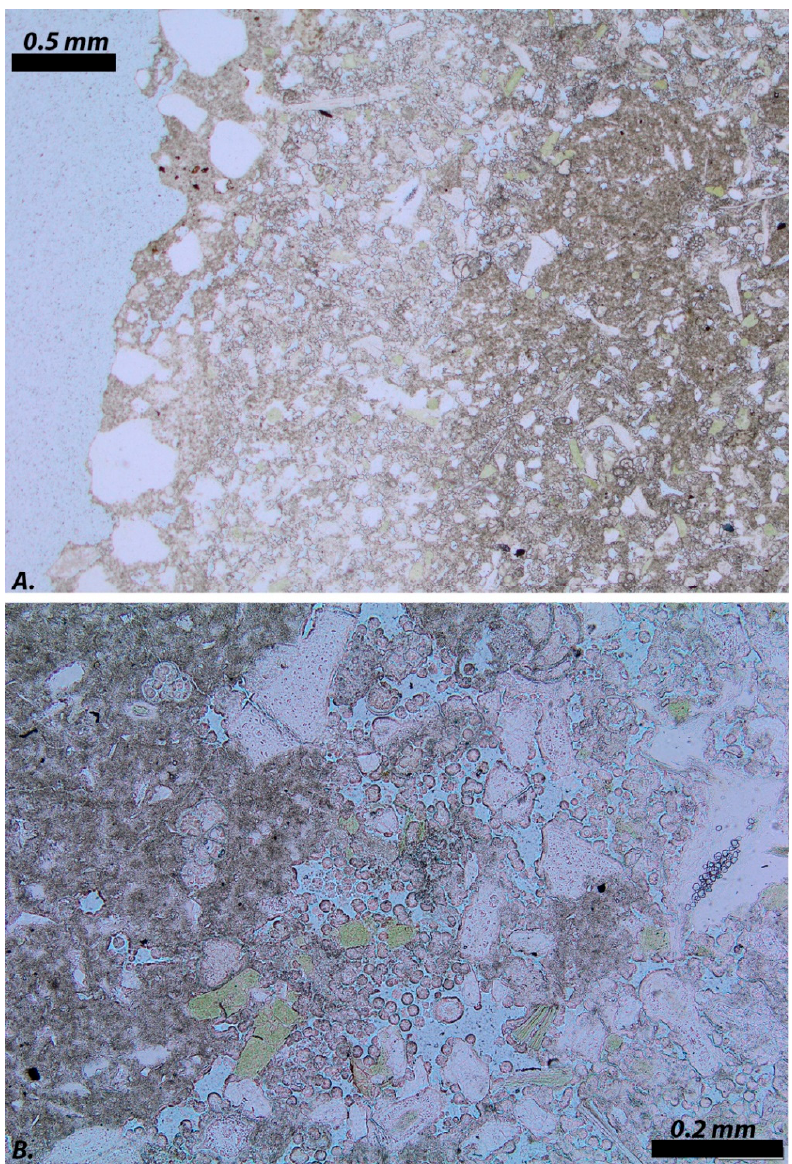
Figure 4. Optical micrographs of material collected from Wardrobe Tower during 2017 conservation work showing interface of Reigate Stone (right) and a hard mortar (left). ( A ) A porous band of Reigate Stone sits between mortar and denser, underlying stone fabric. ( B ) The bond is poor, and the stone fabric displays a high level of dissolution.